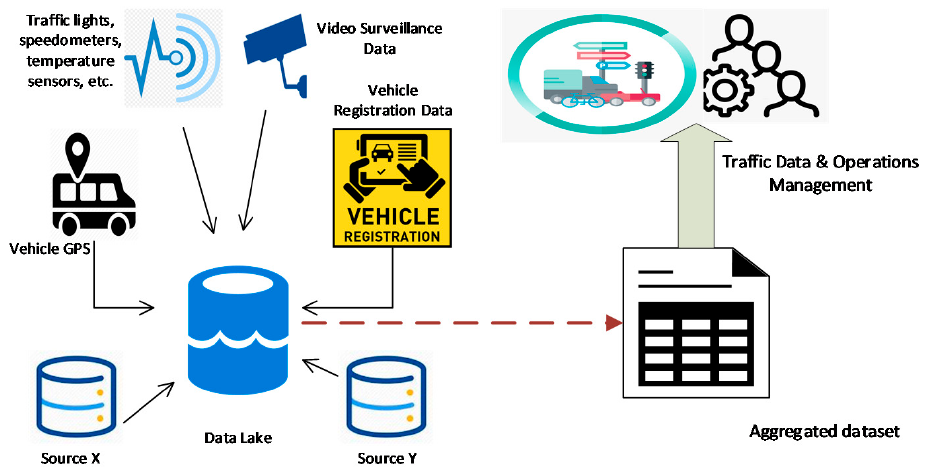
Figure 1. The SC-TMS integrates data from multiple DCs.